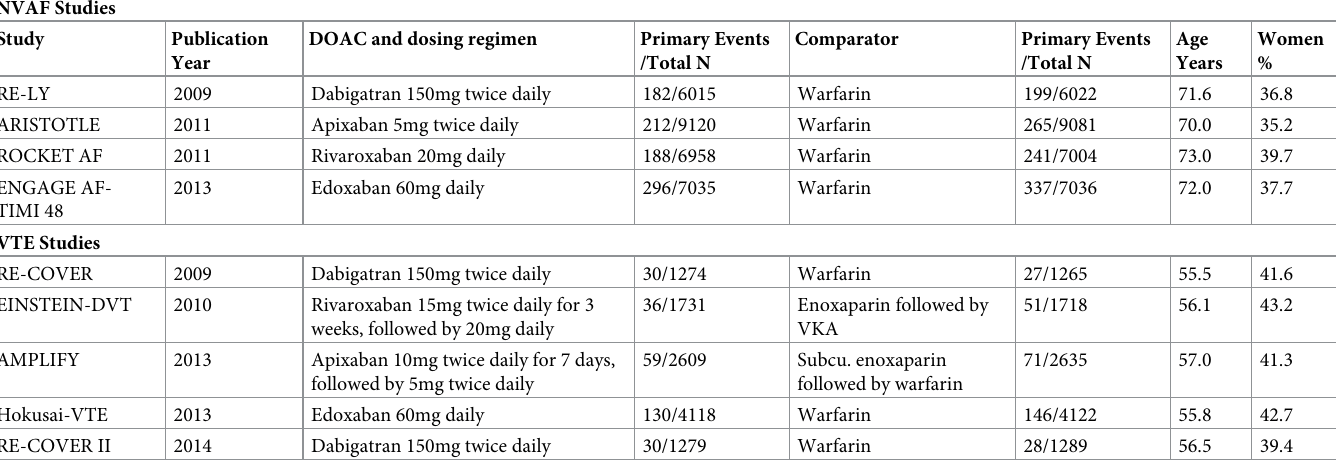
Table 1. Baseline characteristics and corresponding primary efficacy outcomes of the Phase 3 trials